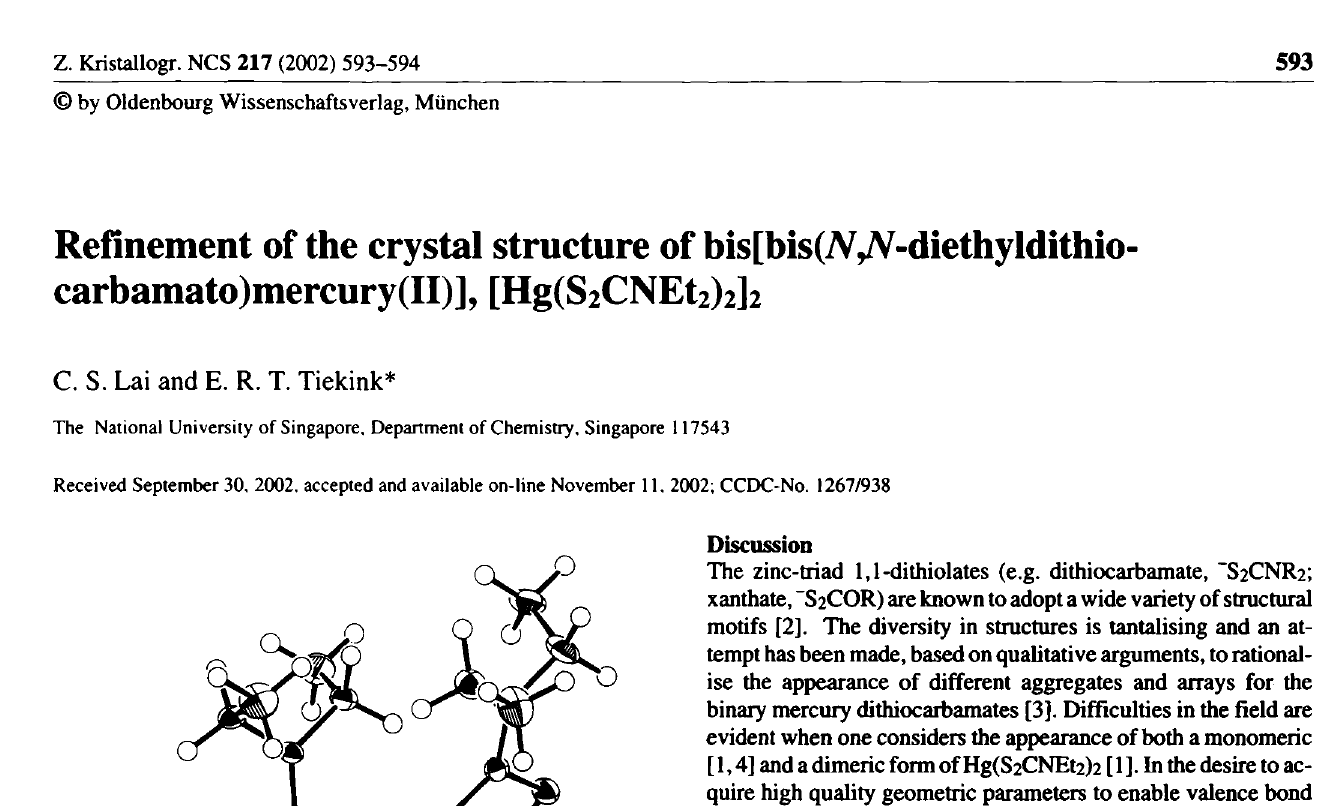
Table 1. Data collection and handling.